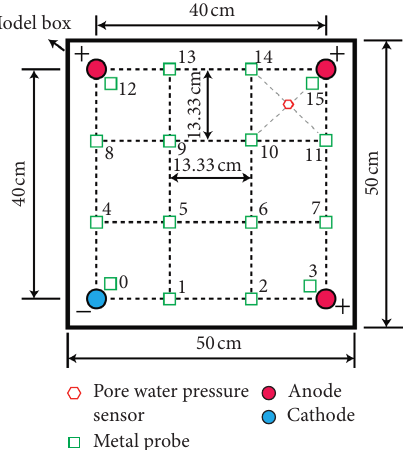
Figure 1: Schematic diagram of electroosmosis test device.